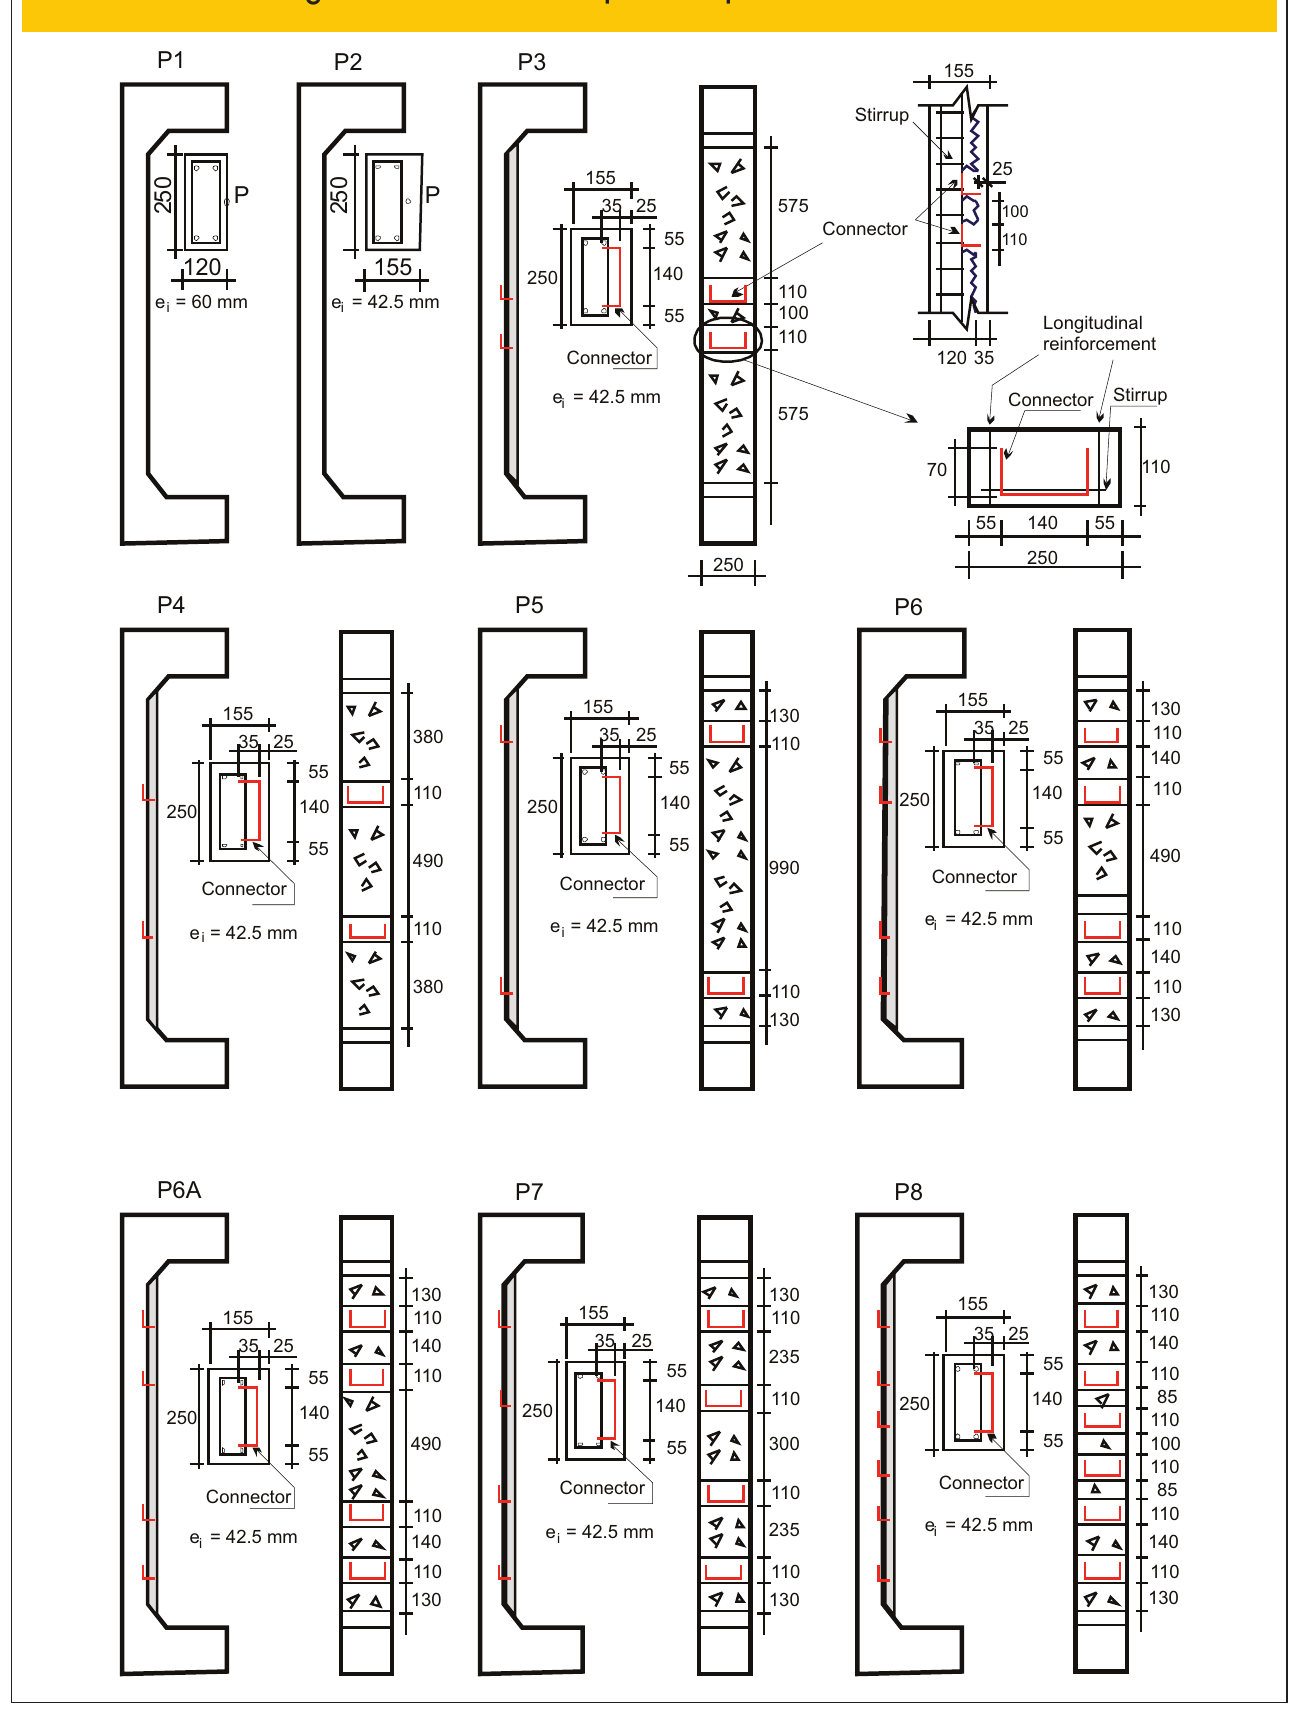
Figure 7 – Location of stirrups at compressed face of